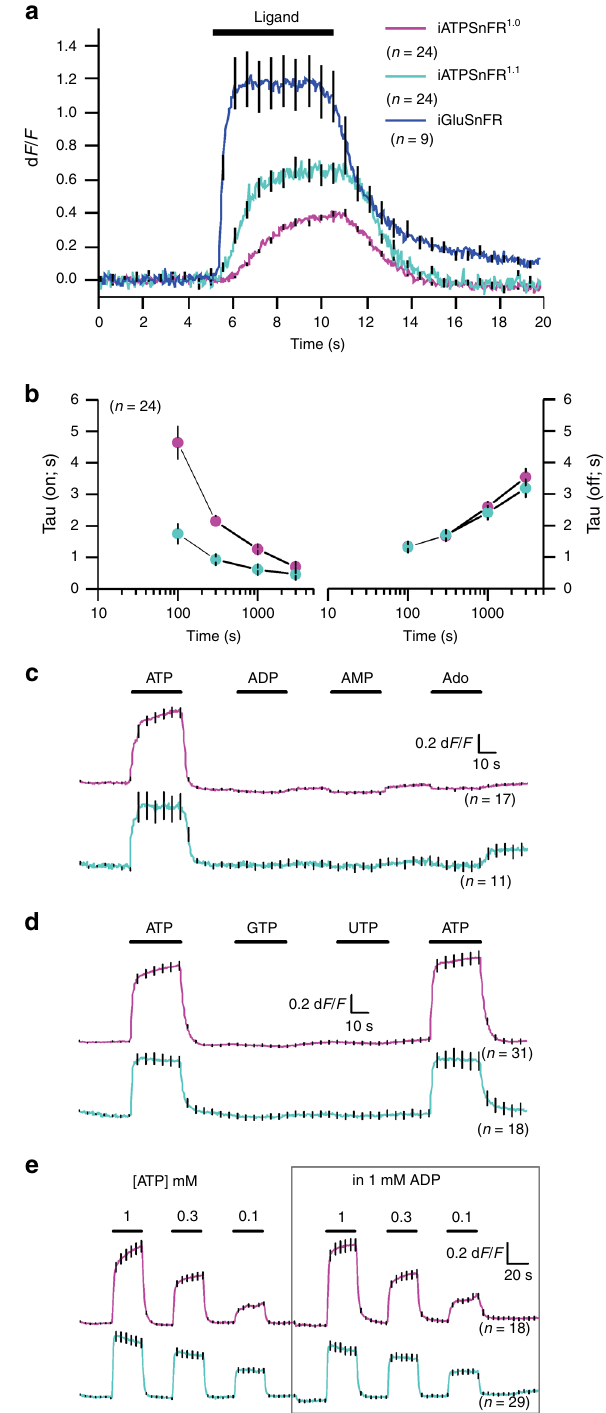
~0.7 d F / F (Fig. 5f). Similar, albeit smaller, responses were observed when we applied ATP to astrocytes expressing or D2 medium spiny neurons expressing iATPSnFR in striatum (Fig. 5g, h). Taken together, these data show that iATPSnFR can be expressed and responds reliably on the surface of cells following in vivo expression.